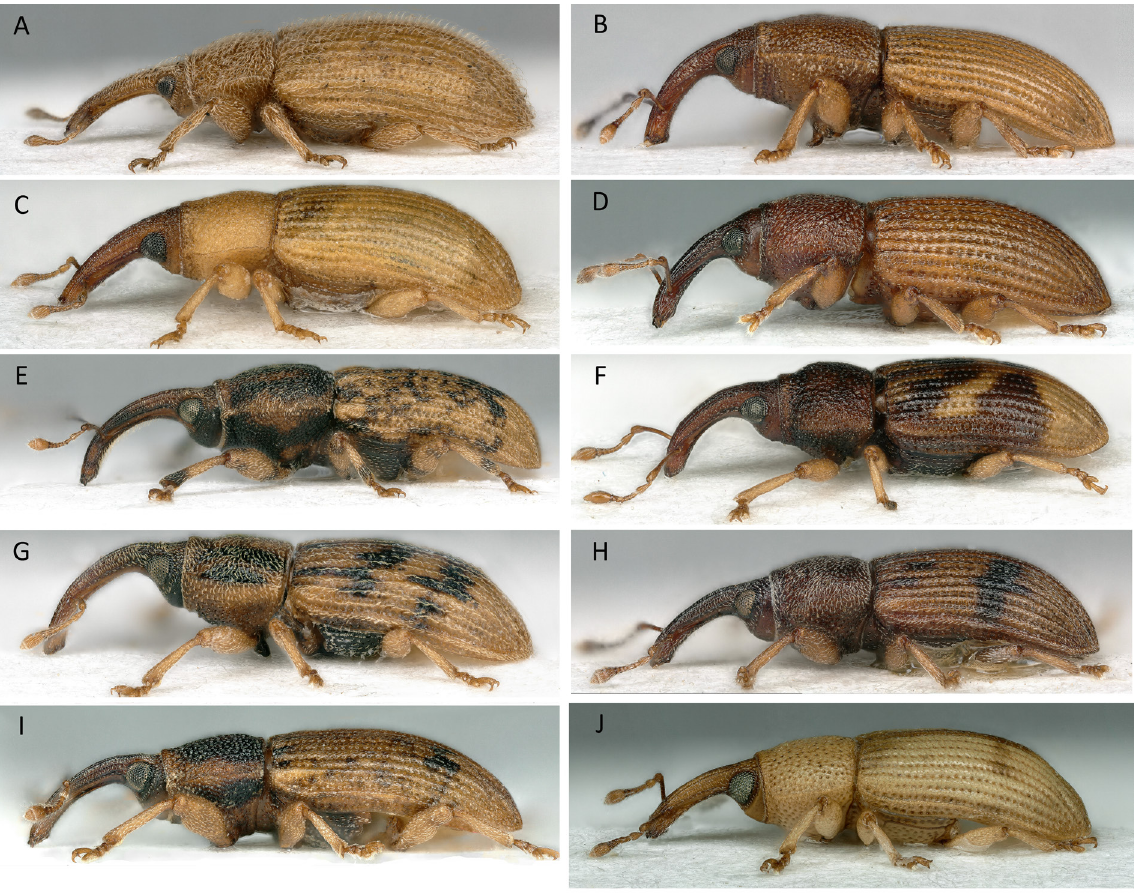
Fig. 4. A–J . Habitus of males of Ebenacobius Haran gen. nov. in lateral view (part 1). A . E.